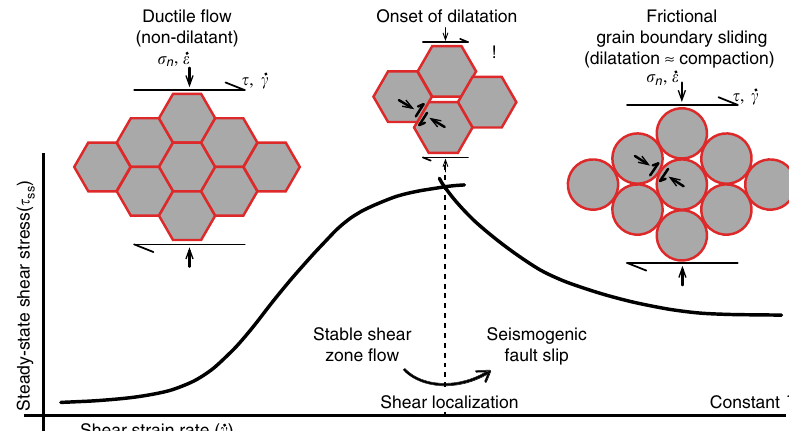
Fig. 5 Representation of the transition from stable shear zone fl ow to seismogenic fault slip. Non-dilatant, ductile fl ow by creep-accommodated grain boundary sliding (GBS) transitions upon the onset of cavitation to a regime of incompletely creep-accommodated GBS and v -weakening frictional sliding. Cavitation occurs because creep processes become too slow to accommodate shear. For the original model formulation, see refs. 35 –